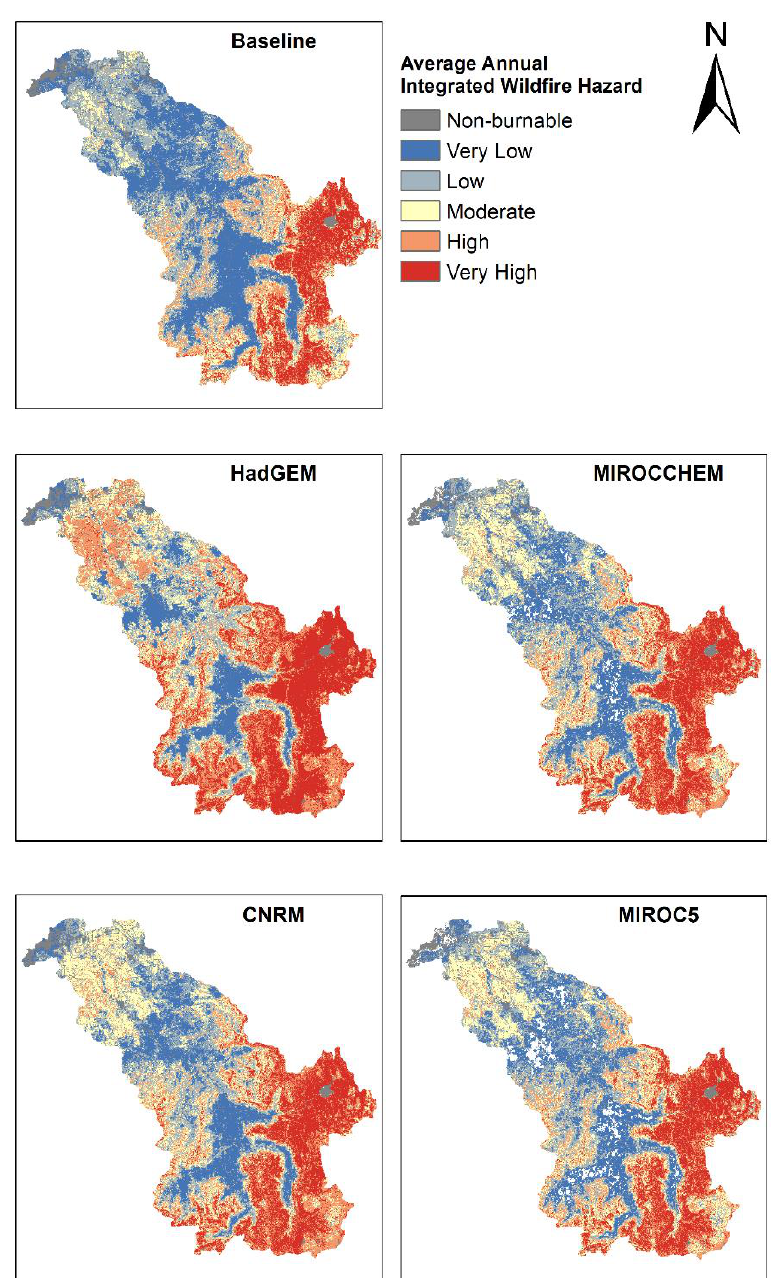
Figure 9. Integrated wildfire hazard is the product of annual burn probability and mean fireline intensity. Baseline wildfire hazard (upper left) under climate conditions based on empirical climate data 1992–2015. The four mid-century scenarios are based on projected climate scenarios. HadGEM is the warmest and driest future scenario, followed by CNRM. Both MIROCCHEM and MIROC5 project small increases in summer relative humidity and are less hot than HadGEM and CNRM, but are still warmer than baseline conditions. Non-burnable pixels indicate water, rock / ice, high density urban areas, and agriculture. Results are classified using a quantile method.